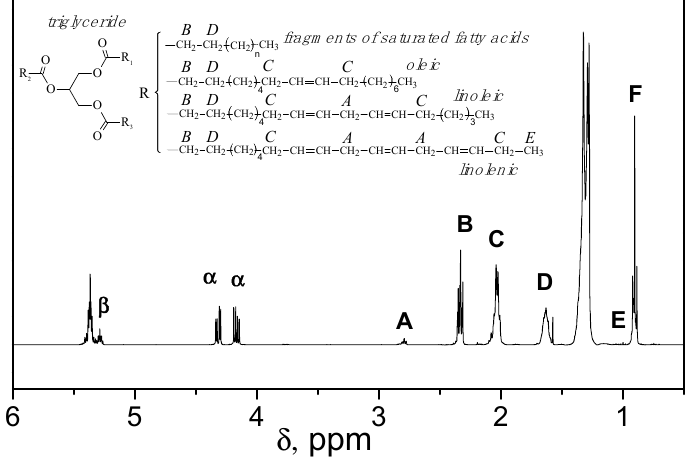
Figure 5. 1 H-NMR spectrum of olive oil. Adapted with permission from [12]. Copyright (2016) American Chemical Society.